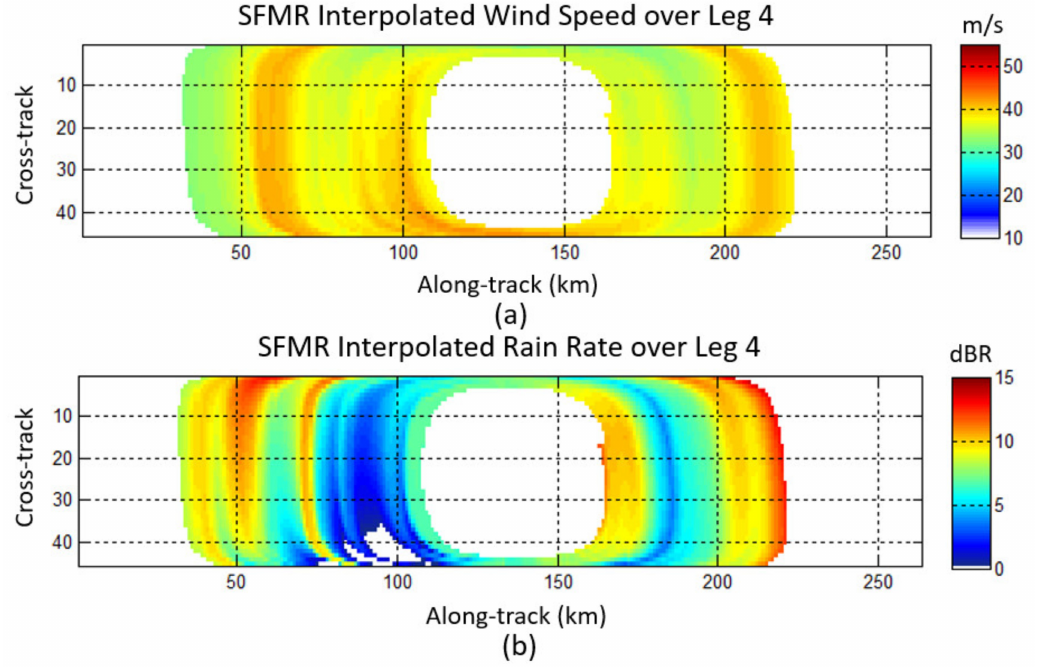
Figure 6. Hurricane Gonzalo model developed using interpolated SFMR WS ( a ) and RR ( b ) onto HIRAD measurement locations for Leg